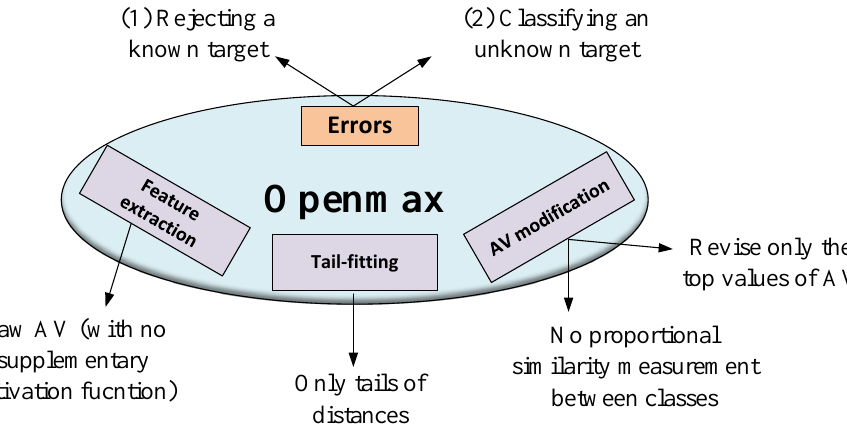
Figure 1. Openmax limitations, source of